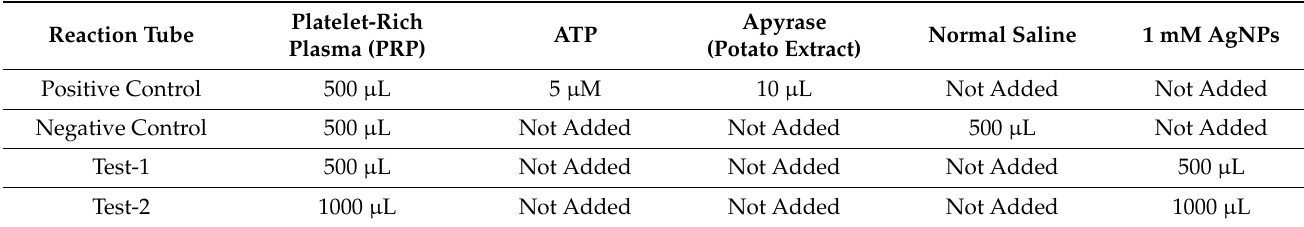
Table 2. Platelet aggregation of AgNPs using platelet-rich plasma.